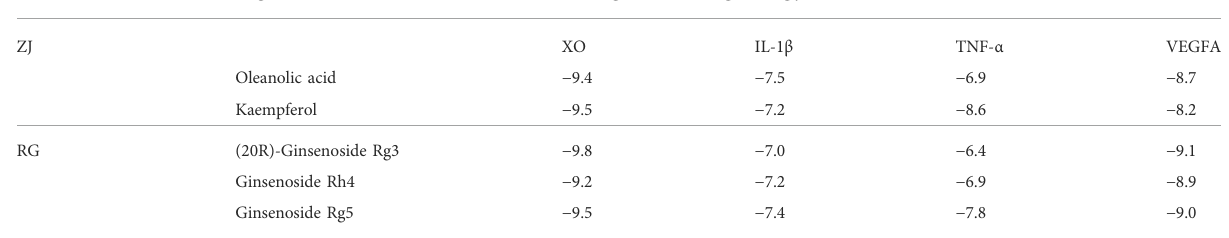
TABLE 4 Docking of core targets with compounds in FGP.